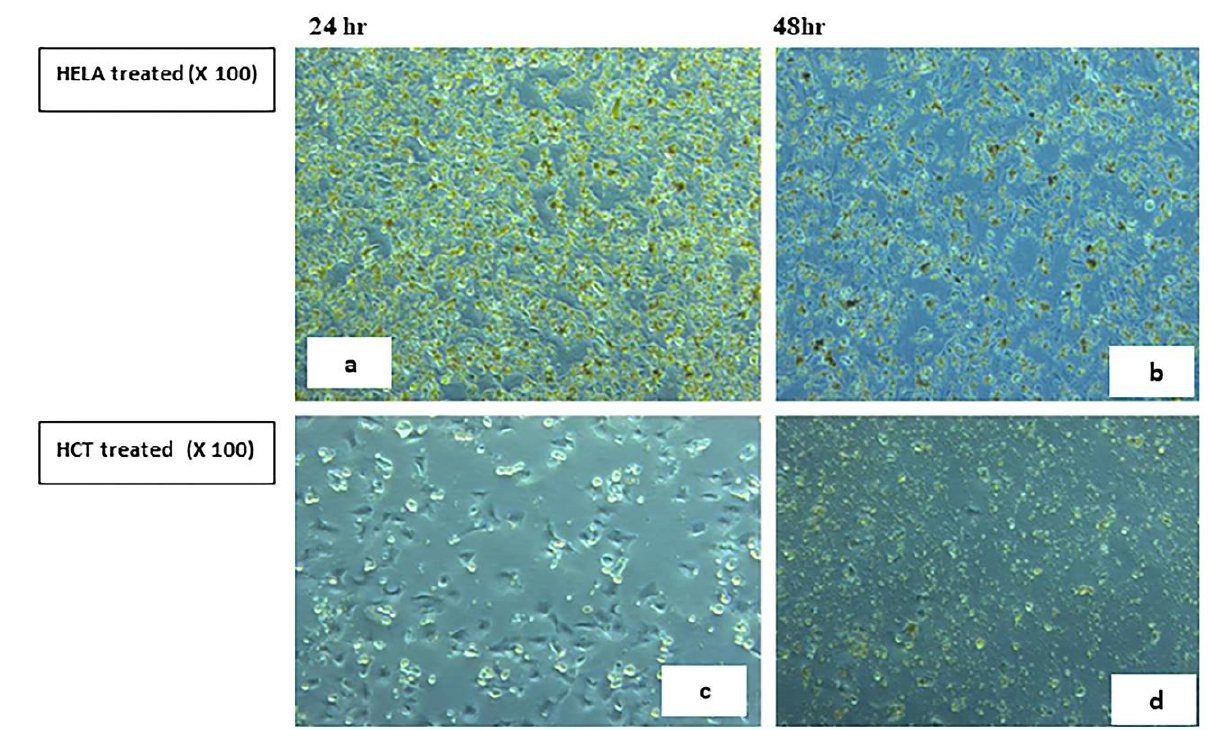
Figure 9. Control (untreated) human HELA &HCT cell lines. Panels ( a , c ) show spindle shaped adherent cells with vesicular nuclei and prominent nucleoli. Panels ( b , d ) show spindle shaped cells. Notice the rounded floating cells (white arrows) and the dividing just attached cells (red arrows). Phase contrast, 400 × .